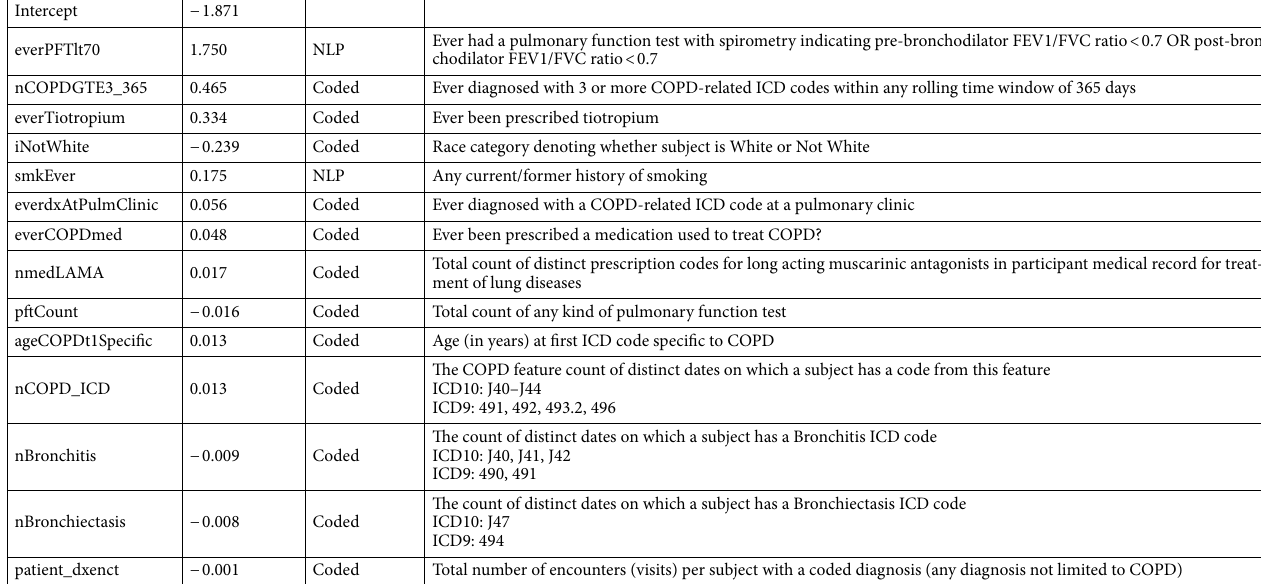
Table 4. Patient medical history features and weights used in the final Mass General Brigham Biobank CRT PFT+ algorithm for classification of COPD. The case assignment threshold for this model, holding specificity at 95%, was 0.754. For subjects who were missing PFT results, the everPFTlt70 variable was classified as ‘No’ in this